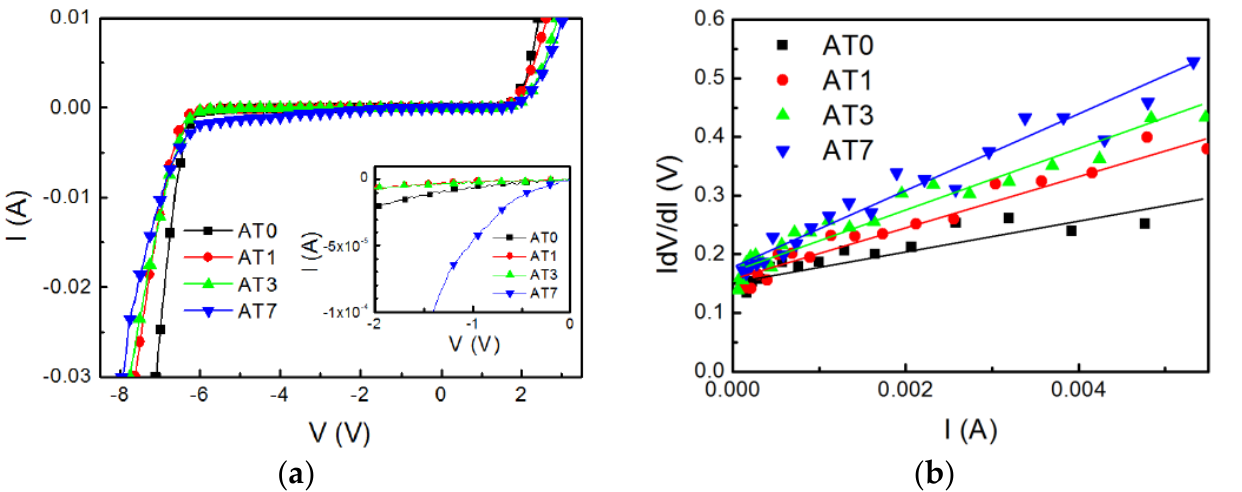
Figure 6. ( a ) The current − voltage (I − V) characteristics of samples AT0, AT1, AT3, and AT7 measured at room temperature. The insect shows the fine-scale in 0 to − 2 V region. ( b ) The IdV/dI − I plot for extracting the diode ideality factor and series resistance. Table 1. The diode ideality factor (n) and series resistance ( Rs ) of the sample AT0, AT1, AT3, and AT7.